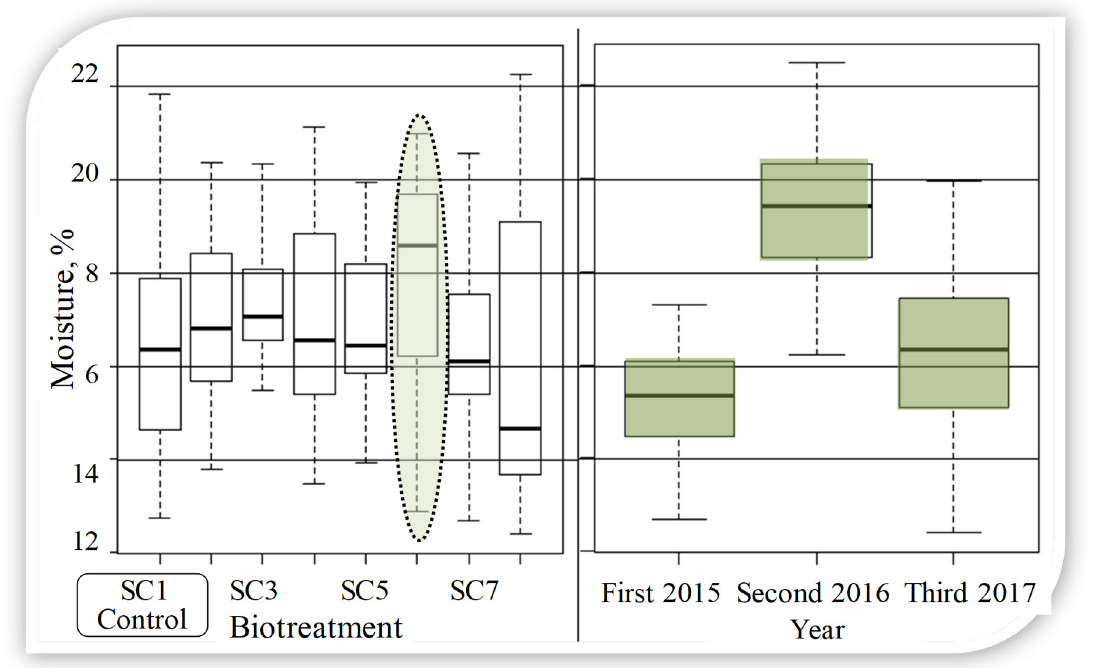
Figure 10. Soil moisture content (%) dependence on bio-impact(s) time (year) and scenario.